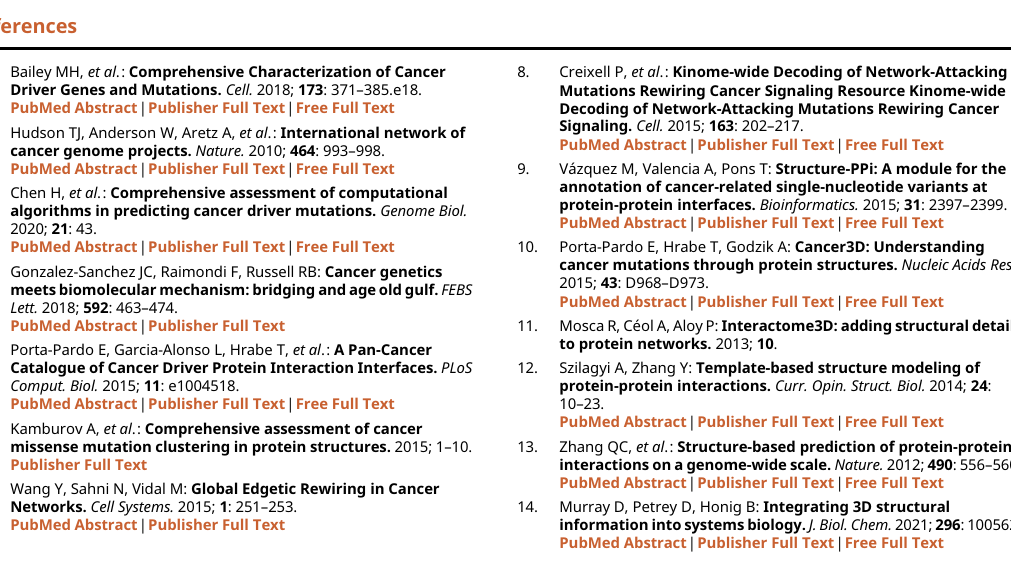
(cid:129) Table S1: Mutation enrichment at protein interaction interfaces. (cid:129) Table S2: Mutation enrichment at Reactome Reactions interfaces. (cid:129) Table S3: Mutation enrichment at Reactome Pathway interfaces. (cid:129) Table S4: Survival analysis of significantly affected interactions. (cid:129) Table S5: Survival analysis of significantly affected reactions. (cid:129) Table S6: Survival analysis of significantly affected